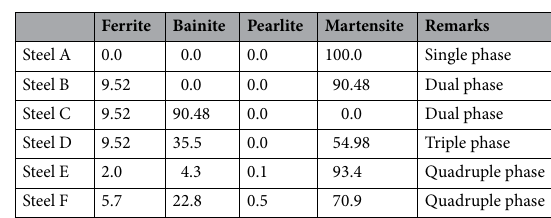
Table 1. Six types of steels with varying compositions of microstructures (all units are in percentage).